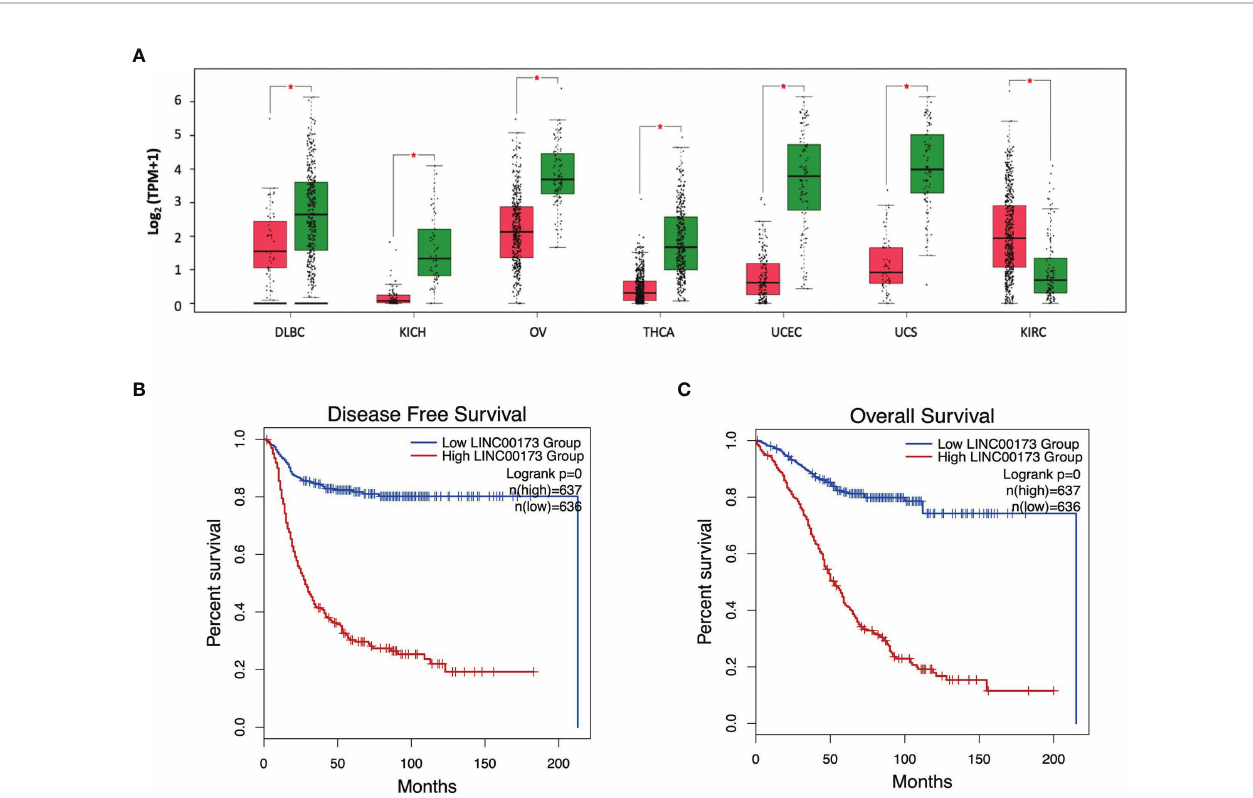
FIGURE 6 | LINC00173 expression is dysregulated in multiple human cancers. (A) Expression of LINC00173 displays differences in DLBC, KICH, OV, THCA, UCEC, UCS, and KIRC tumors, which was not previously reported. (B) Disease free-survival and (C) overall survival analysis in these seven types of cancer. Green box: normal tissue samples, red box: tumor samples. Data obtained from GEPIA2 (http://gepia2.cancer-pku.cn/#index). DLBC, diffuse large B-cell lymphoma; KICH, kidney chromophobe; OV, serous cystadenocarcinoma; THCA, thyroid carcinoma; UCEC, uterine corpus endometrial carcinoma; UCS, uterine carcinosarcoma; and KIRC, kidney renal clear cell